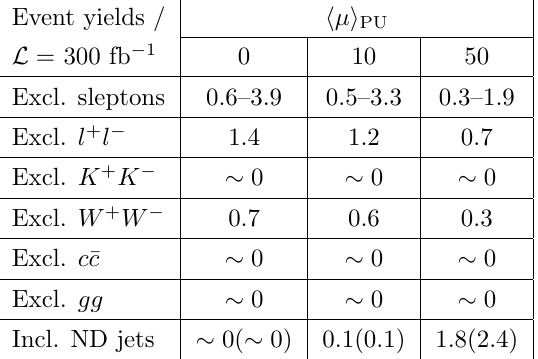
< 40 GeV and lepton 5 1 l 2 ; M ) = (120 ; 110) GeV scenario. The value l e (cid:31) 0 1